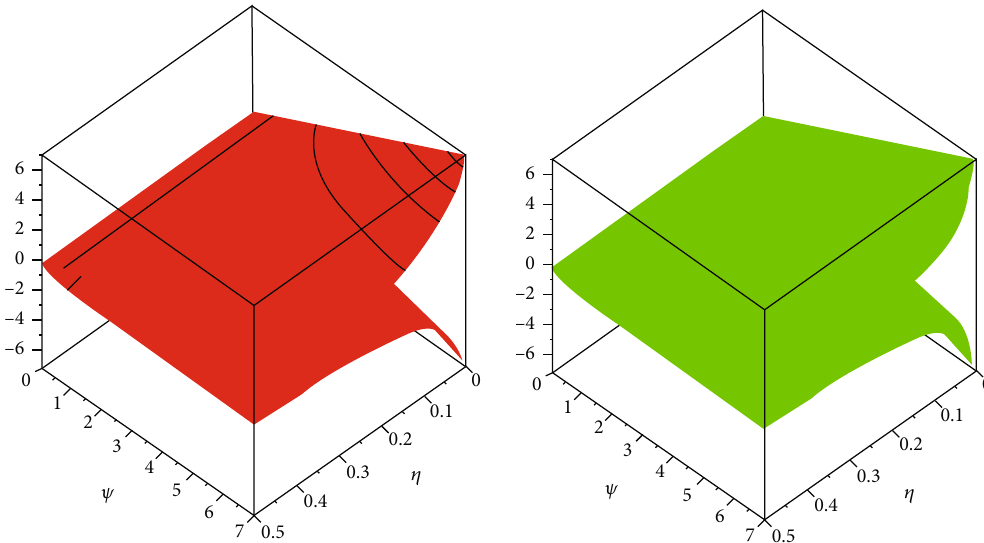
Figure 1: The fi rst graph shows the fuzzy 3D upper and lower fi gure of analytical solution at γ = 1 and the second graph at fractional of γ = 0 : 8